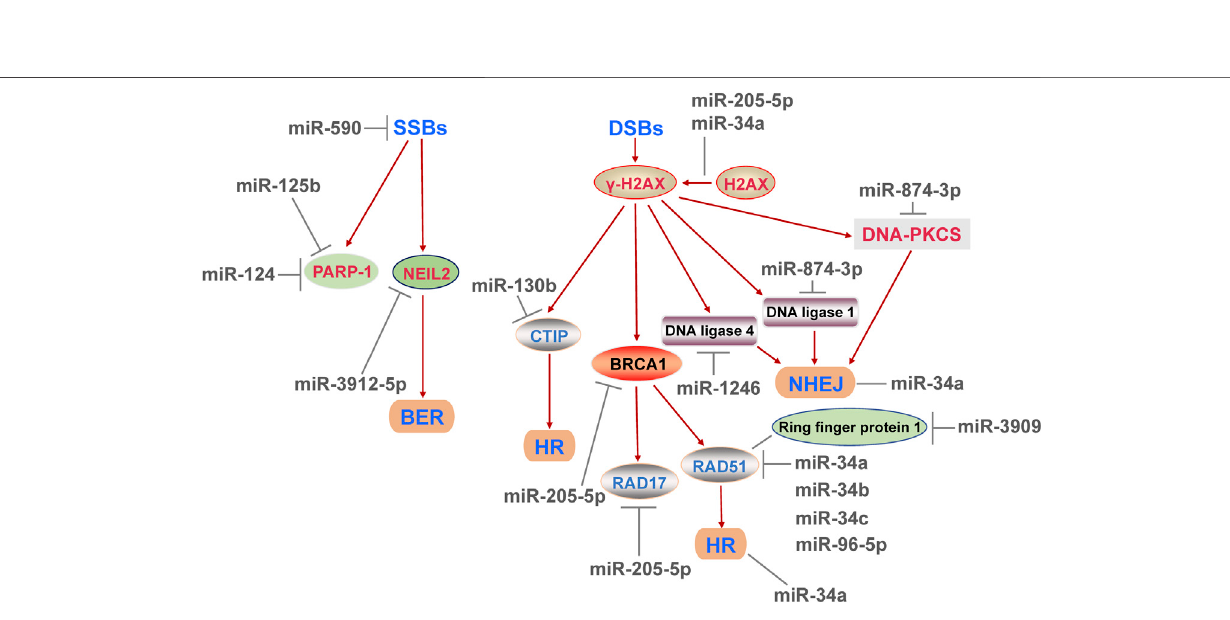
Frontiers in Genetics |